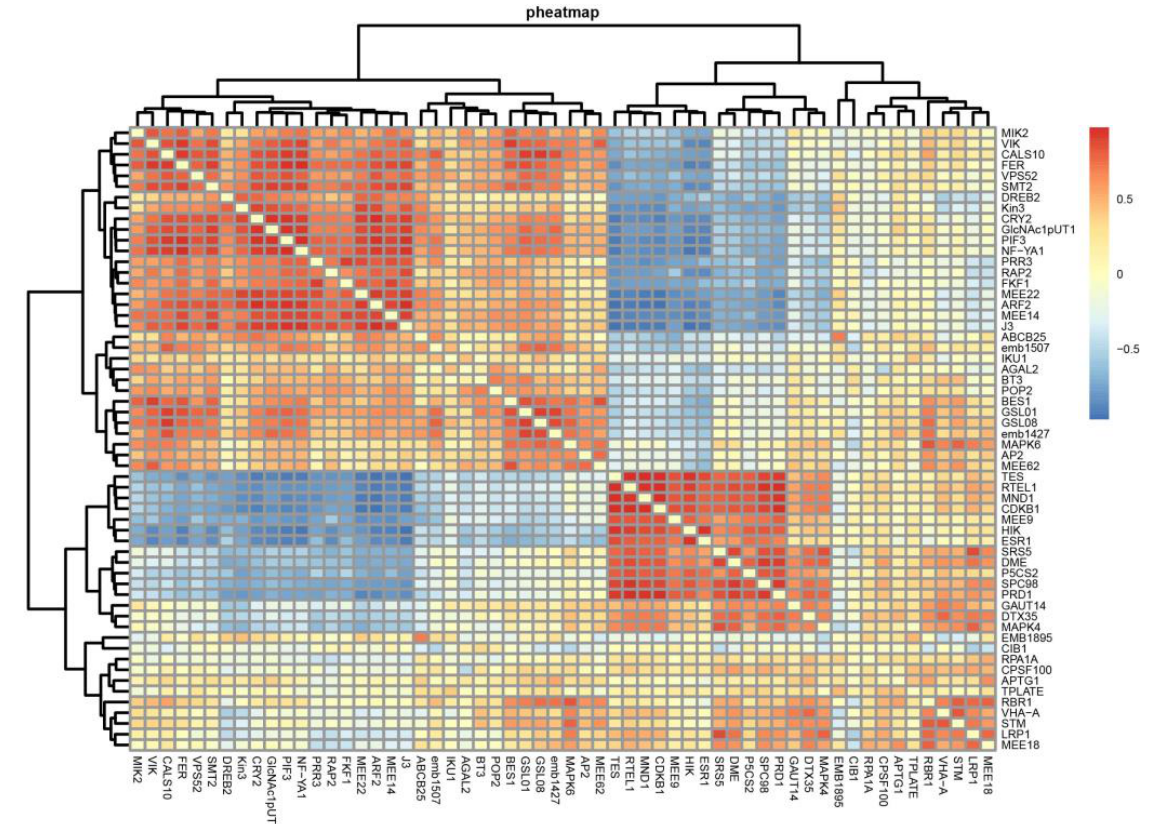
Figure 12. Correlation analysis of reproductive-related genes. The genes were divided into two clusters, and the genes in each group were positively correlated. Genes in one of the clusters were associated with photoperiodic flowering, brassinosteroid response pathway, and flowering time regulation. Another cluster was related to determining the transformation of leaf buds into flower buds in response to photoperiod and flower development. The correlation between genes was then calculated using the Pearson method of the cor function with log (TPM + 1) expression values. The scale bar unit was log TPM + 1.